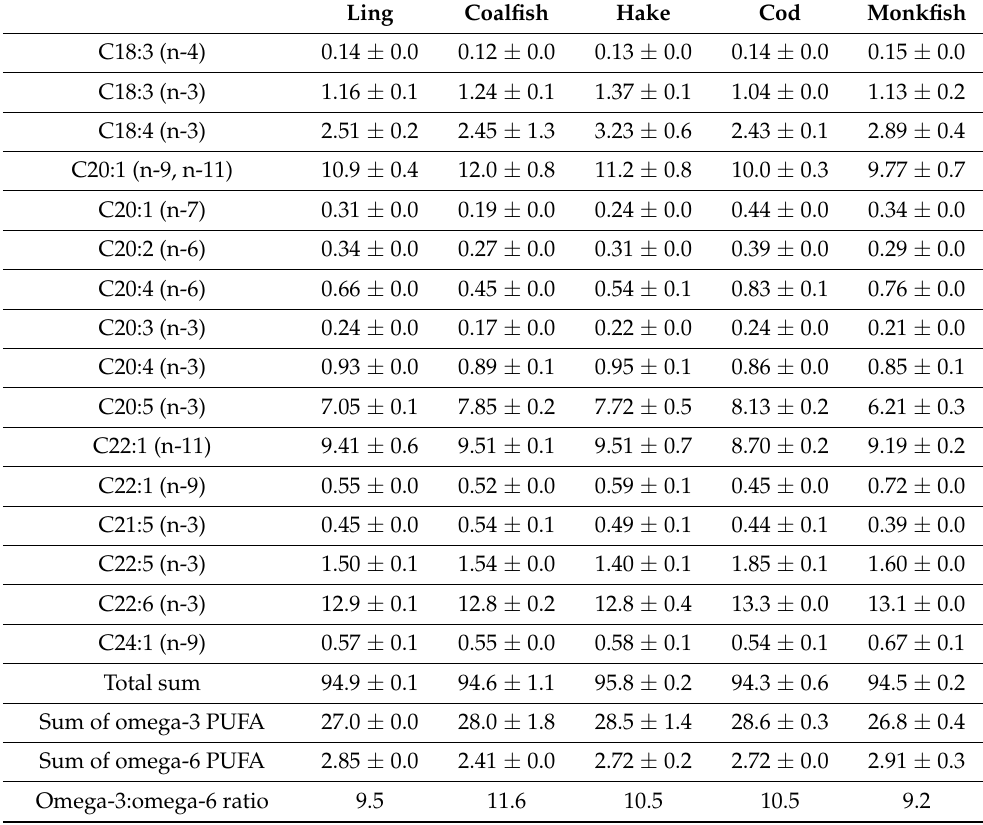
Table 3. Cont. Ling Coalfish Hake Cod